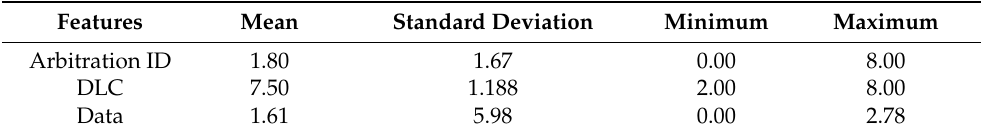
Table 7. Statistical